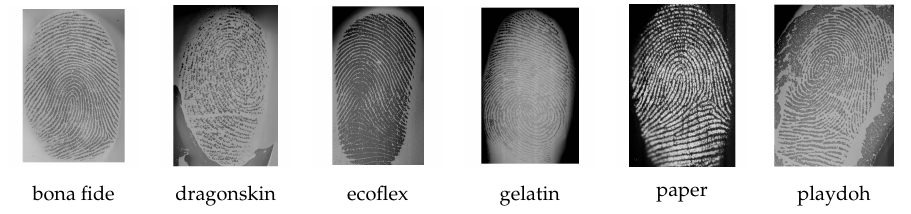
Figure 2. A bona fide fingerprint and five different